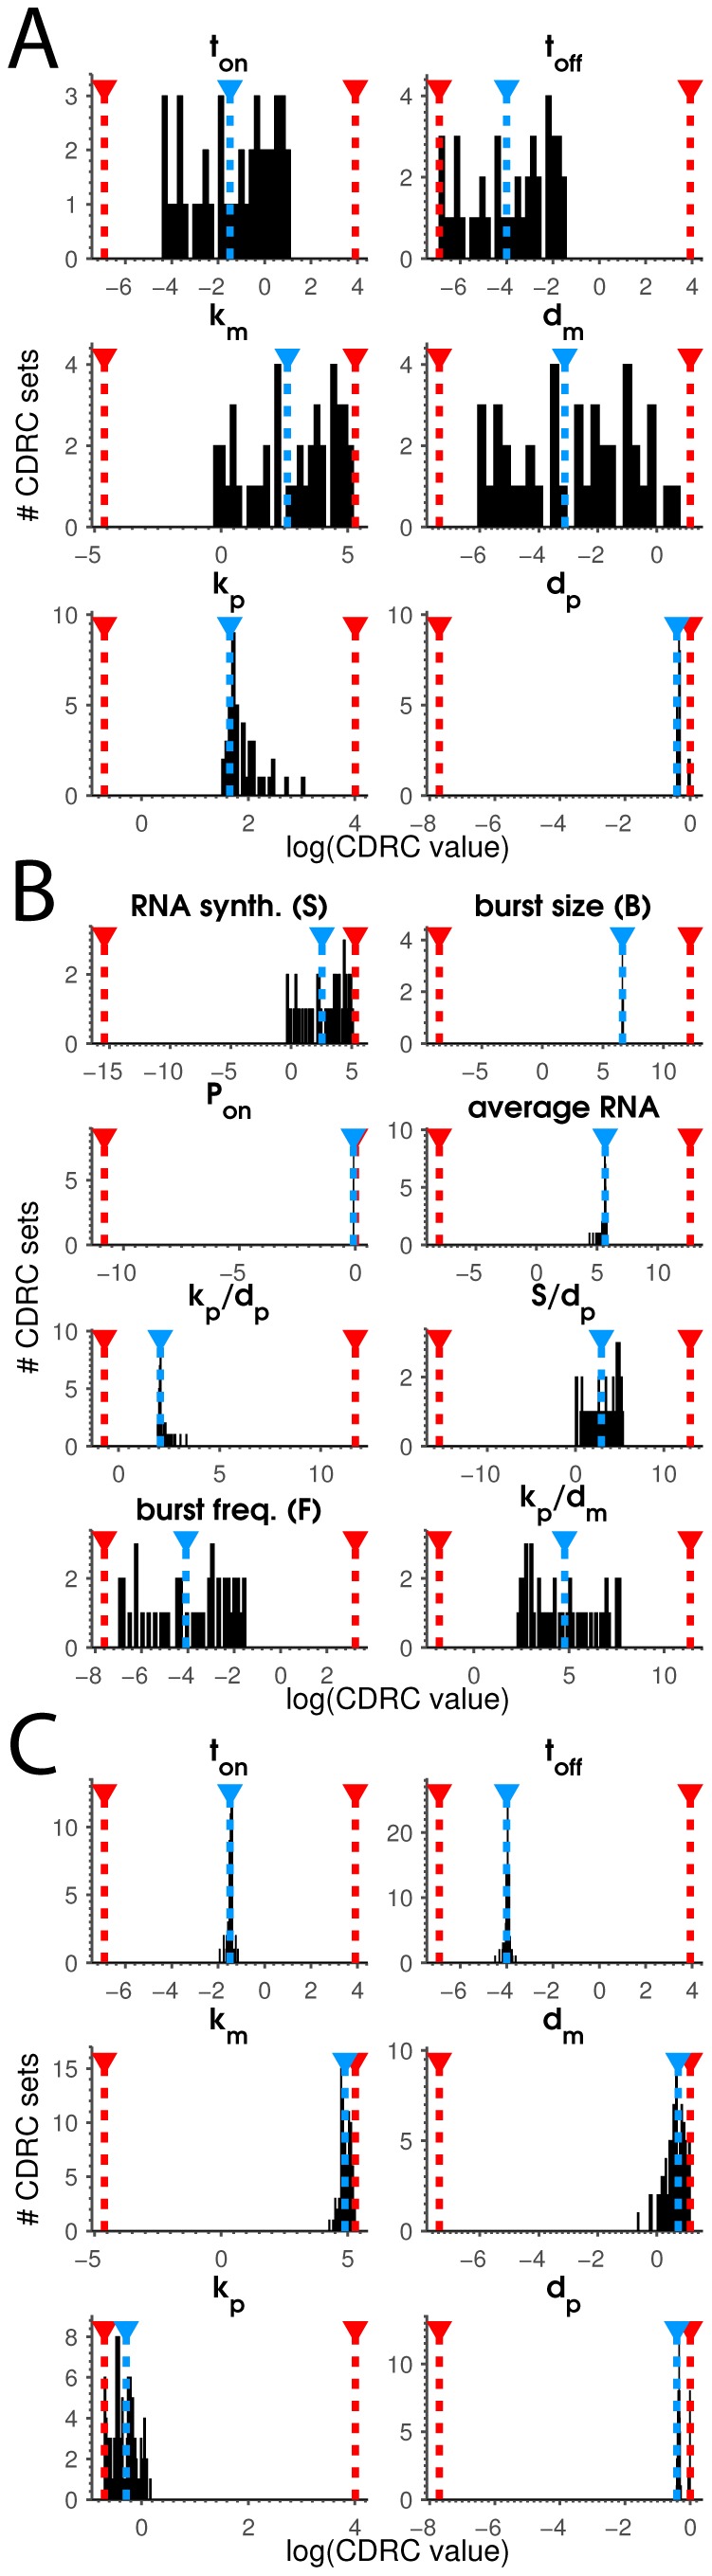
Fitting CDRCs from moments.Plotted is a histogram of CDRC solutions separated by parameter. Blue lines show the value of the input CDRC parameter, and red lines denote each CDRC's minimum and maximum value. A CDRC solution sets for fitting library member 3515 with CDRC input values (), demonstrate only some parameters are well fit from four moments in this example. B Solution CDRC ratios from the same output set in (A) (library member 3515) reveal some CDRC ratios are well identified. C CDRC solution sets for fitting library member 3585, with input CDRC values (), demonstrate all parameters are well fit from four moments in this example.